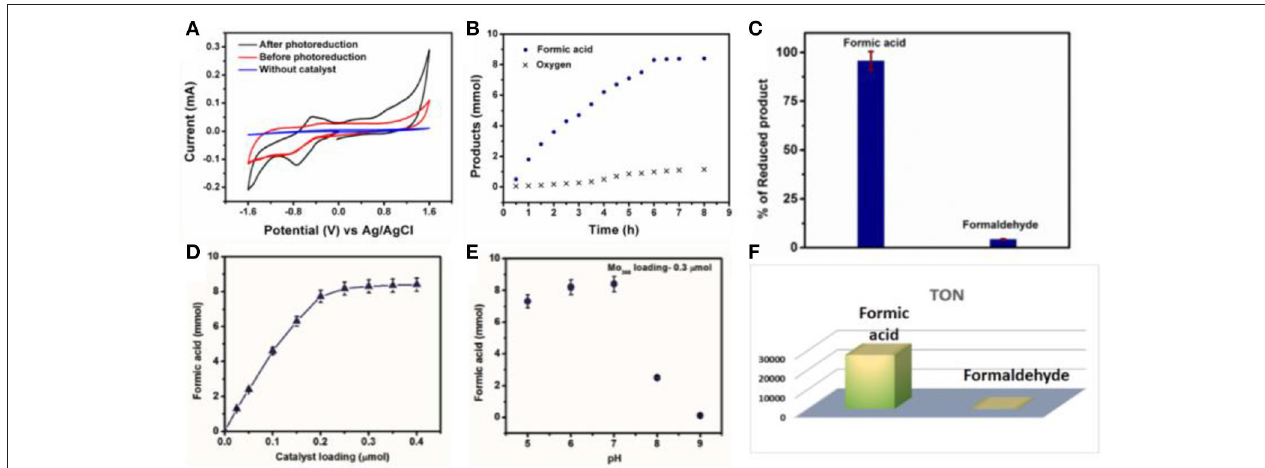
FIGURE 3 | (A) Cyclic voltammogram of the reaction mixture, blue line corresponds to blank where there is neither CO 2 nor catalyst, red line corresponds to CO 2 addition without UV light illumination and black line corresponds to photo CO 2 reduction in water using {Mo 368 } as a catalyst. (B) Time dependent formic acid and oxygen formation by photochemical carbon dioxide reduction using {Mo 368 } as a catalyst. (C) Formation of different reduced product using {Mo 368 }, and their respective percentage yield in total CO 2 reduced product. (D) Effect of variation of {Mo 368 } loading on formation of formic acid. (E) pH dependent formic acid formation using {Mo 368 } as a catalyst. (F) TON of the formic acid and formaldehyde [Amount of product formed (mol)/amount of catalyst taken (mol)].